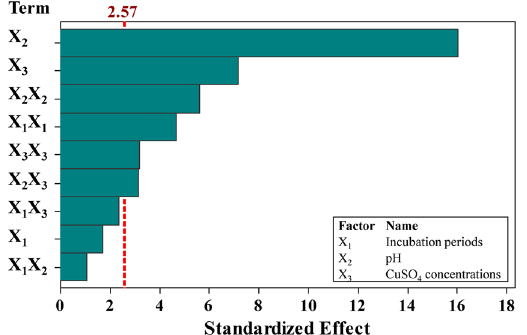
Figure 3. Pareto chart of the standardized effects of the tested parameters on Cu 2 + removal % by Azotobacter nigricans